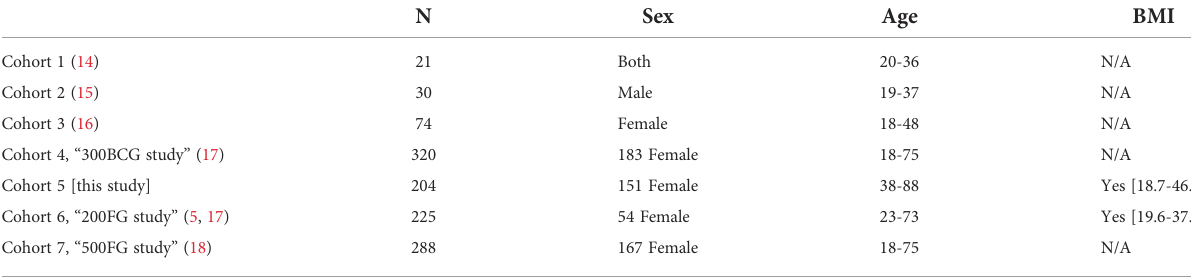
TABLE 1 An overview of the characteristics of the validation cohorts in which IL-38 concentrations were